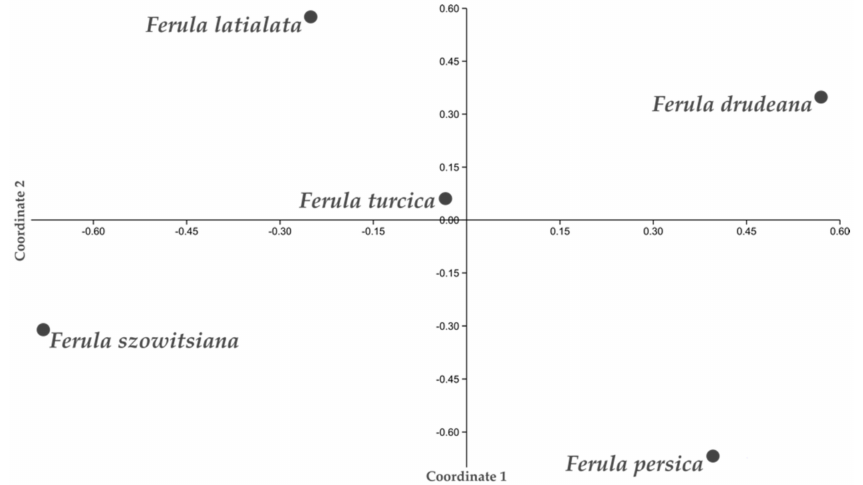
Figure 6. Principal coordinate analysis performed on 21 morphological, anatomical, and chemical characters of Ferula turcica , F. latialata , and related